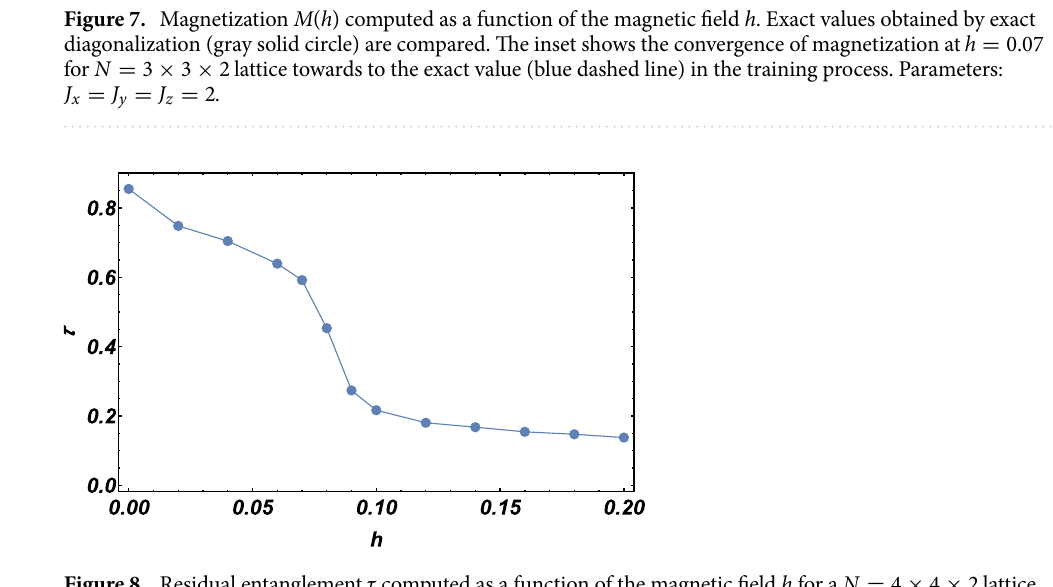
Figure 8. Residual entanglement τ computed as a function of the magnetic field h for a N = 4 × 4 × 2 lattice. Parameters: J x = J y = J z = 2